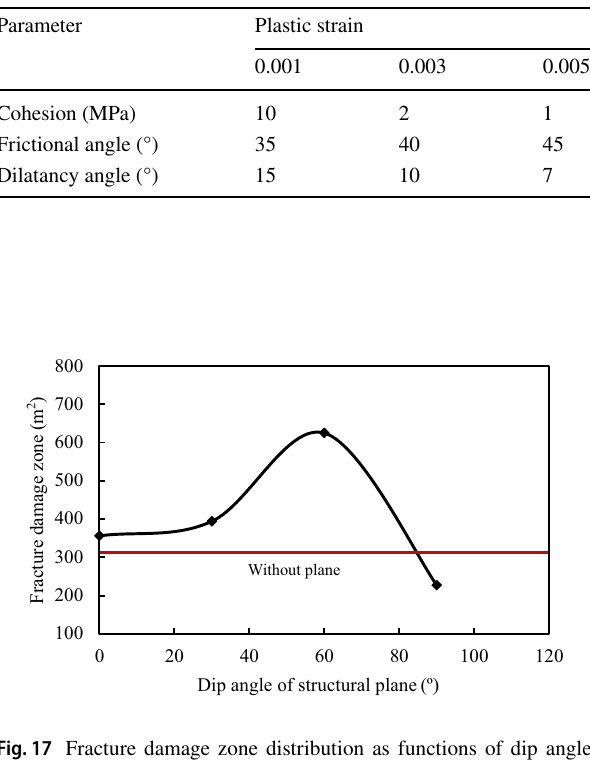
Fig. 17 Fracture damage zone distribution as functions of dip angle of structural plane subjected to vertical dynamic